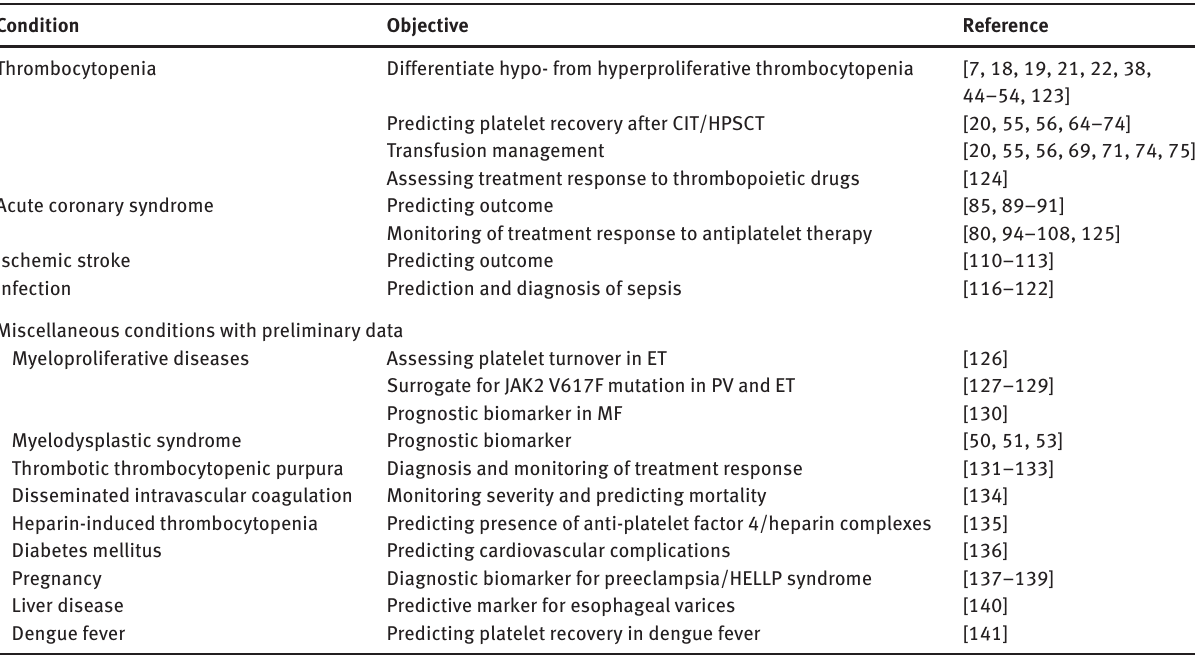
Table 1: Clinical applications for reticulated